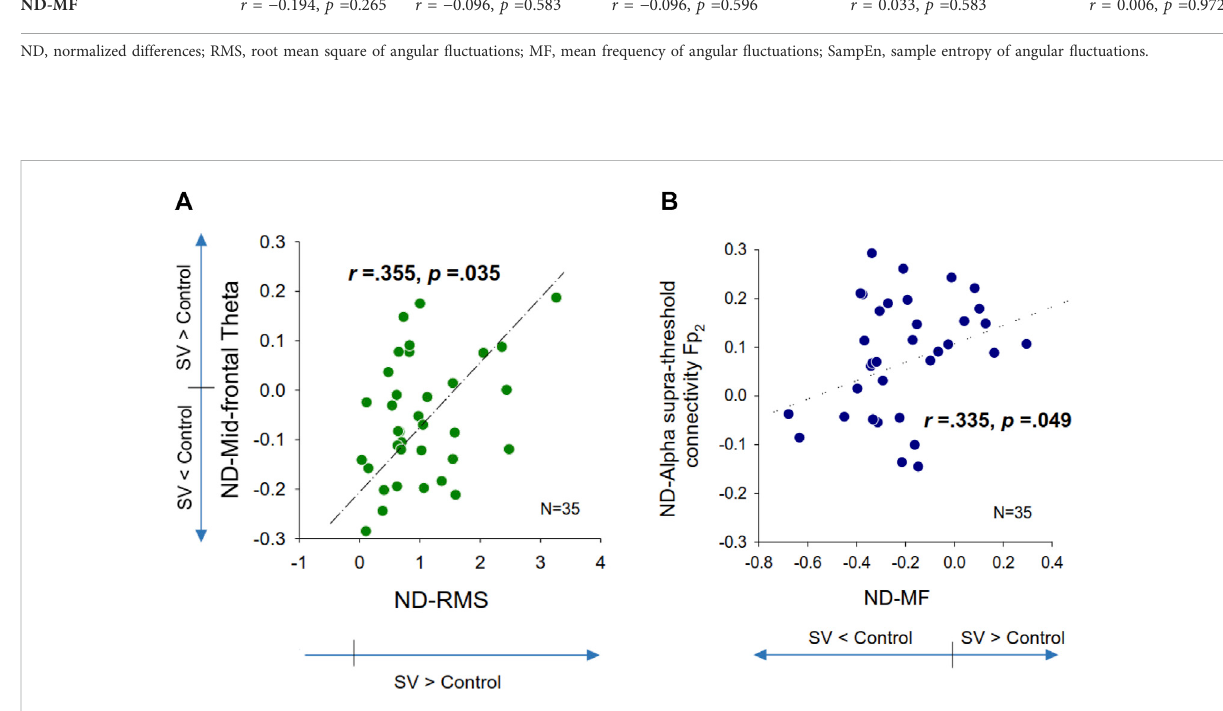
FIGURE 5 Scatter plots of normalized differences (ND) in EEG variables and normalized differences in postural fl uctuation variables that are signi fi cantly correlated. (A) ND in mid-frontal theta vs. ND inrootmean square ofpostural fl uctuations, (B) ND in supra-threshold connectivityof Fp 2 in thealpha band vs. ND in mean frequency (MF) of postural fl uctuations.